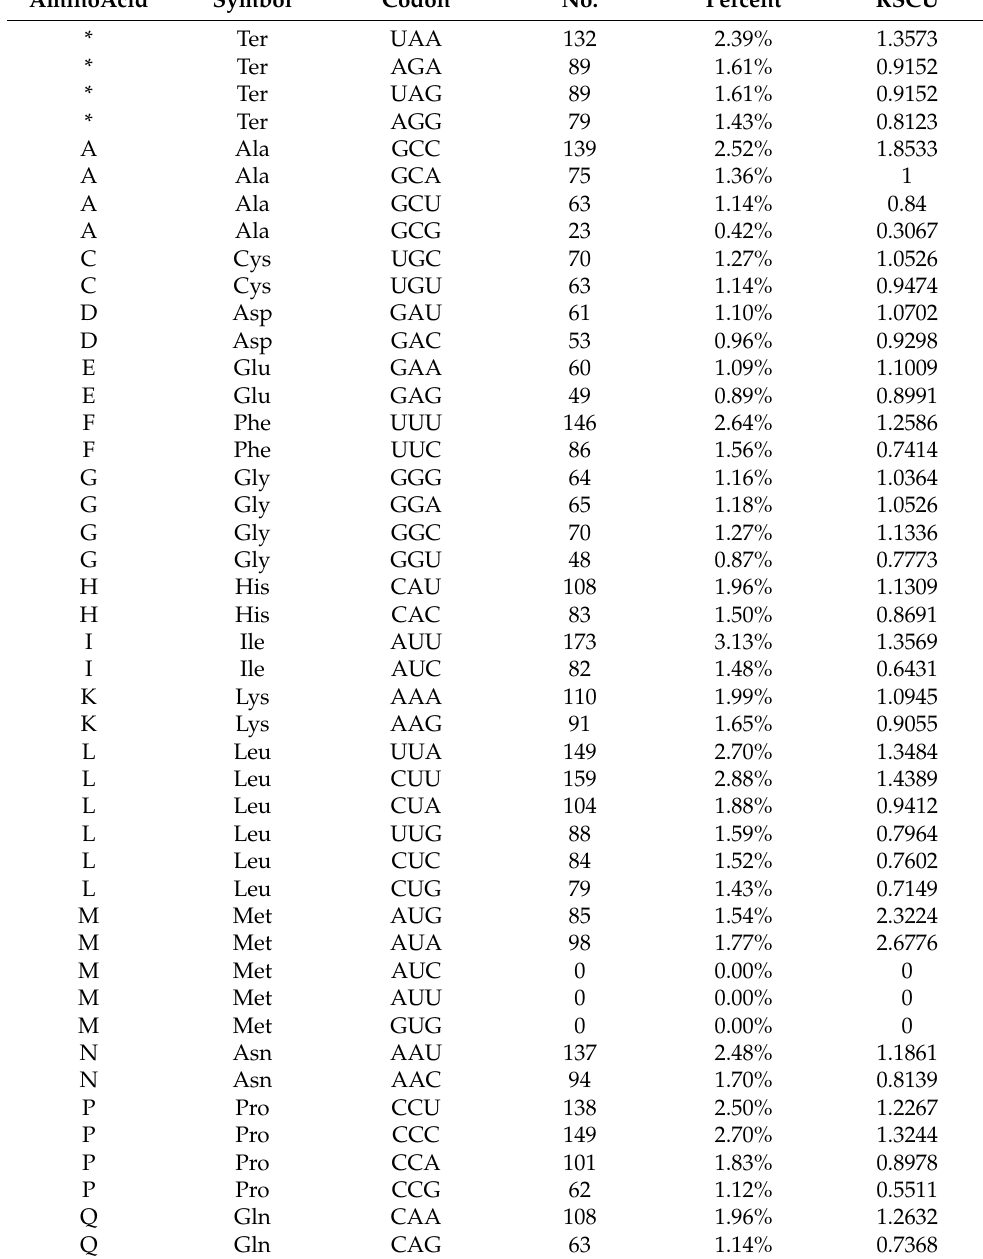
Table 3. Codon usage in the T. bombifrons